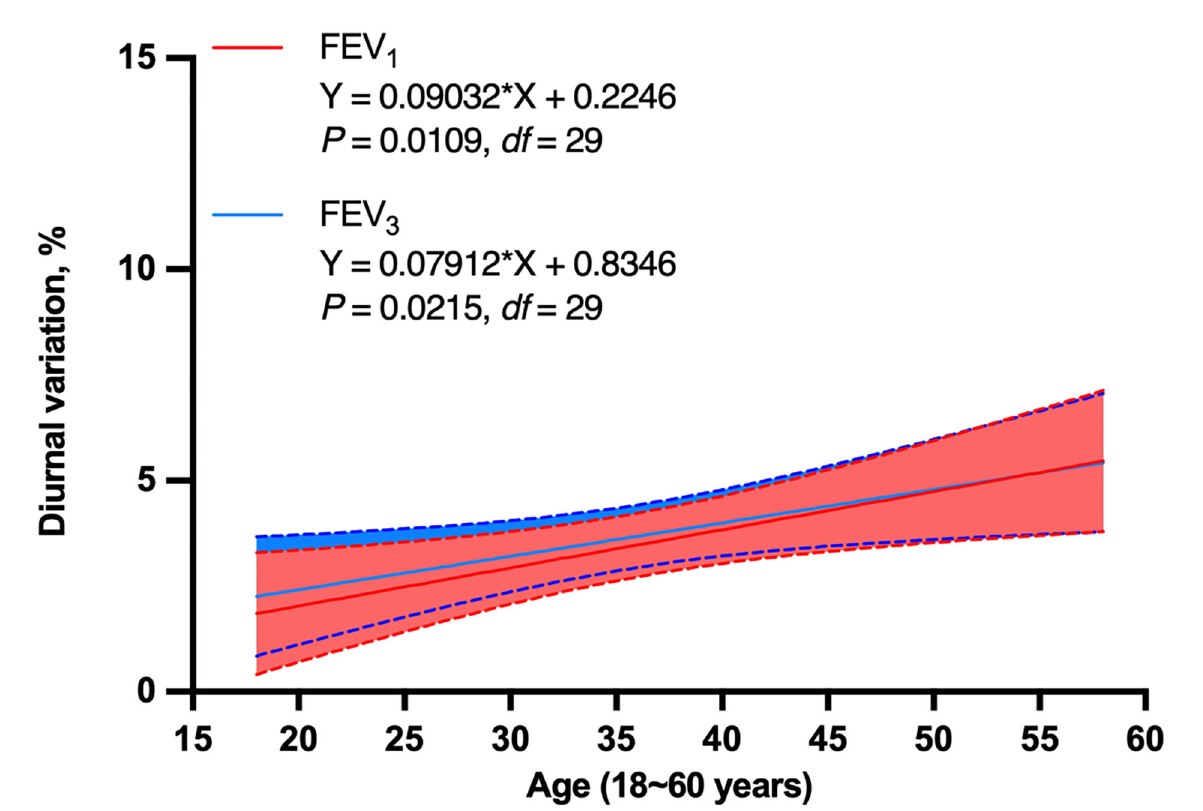
FIGURE6 Simple linear regression of diurnal variation of FEV 1 and FEV 3 with age in non-smoking healthy adults ( N = 30). Diurnal variation of FEV 1 and FEV 3 were positively related to age in non-smoking healthy adults ( P = 0.0109, df = 29 for FEV 1 and P = 0.0215, df = 29 for FEV 3 ). FEV 1 , forced expiratory volume in 1s; FEV 3 , FEV in 3s; df , degree of freedom.